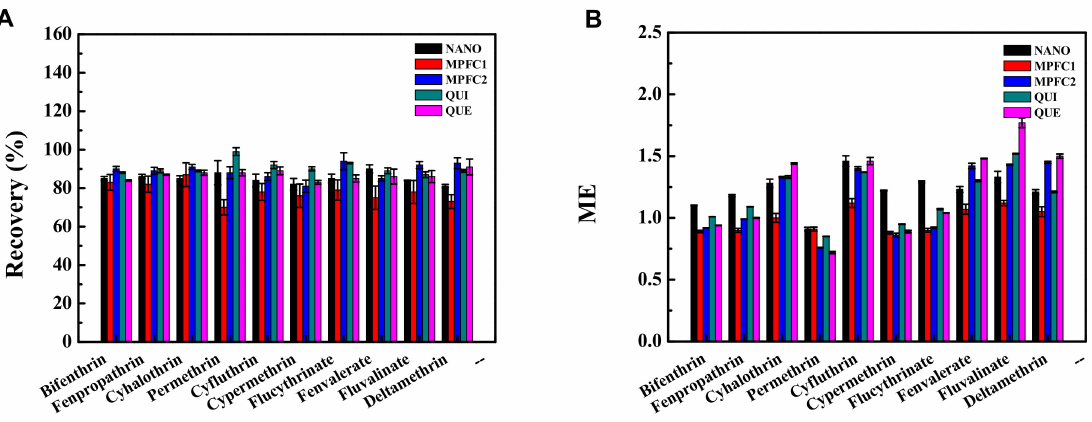
Figure 2. ( A ) The effect of different purification columns on the recovery rate of pyrethroid pesticides in a simple matrix (cucumber) ( n = 3). ( B ) Matrix effect of pyrethroid pesticides in the simple matrix (cucumber) under different purification